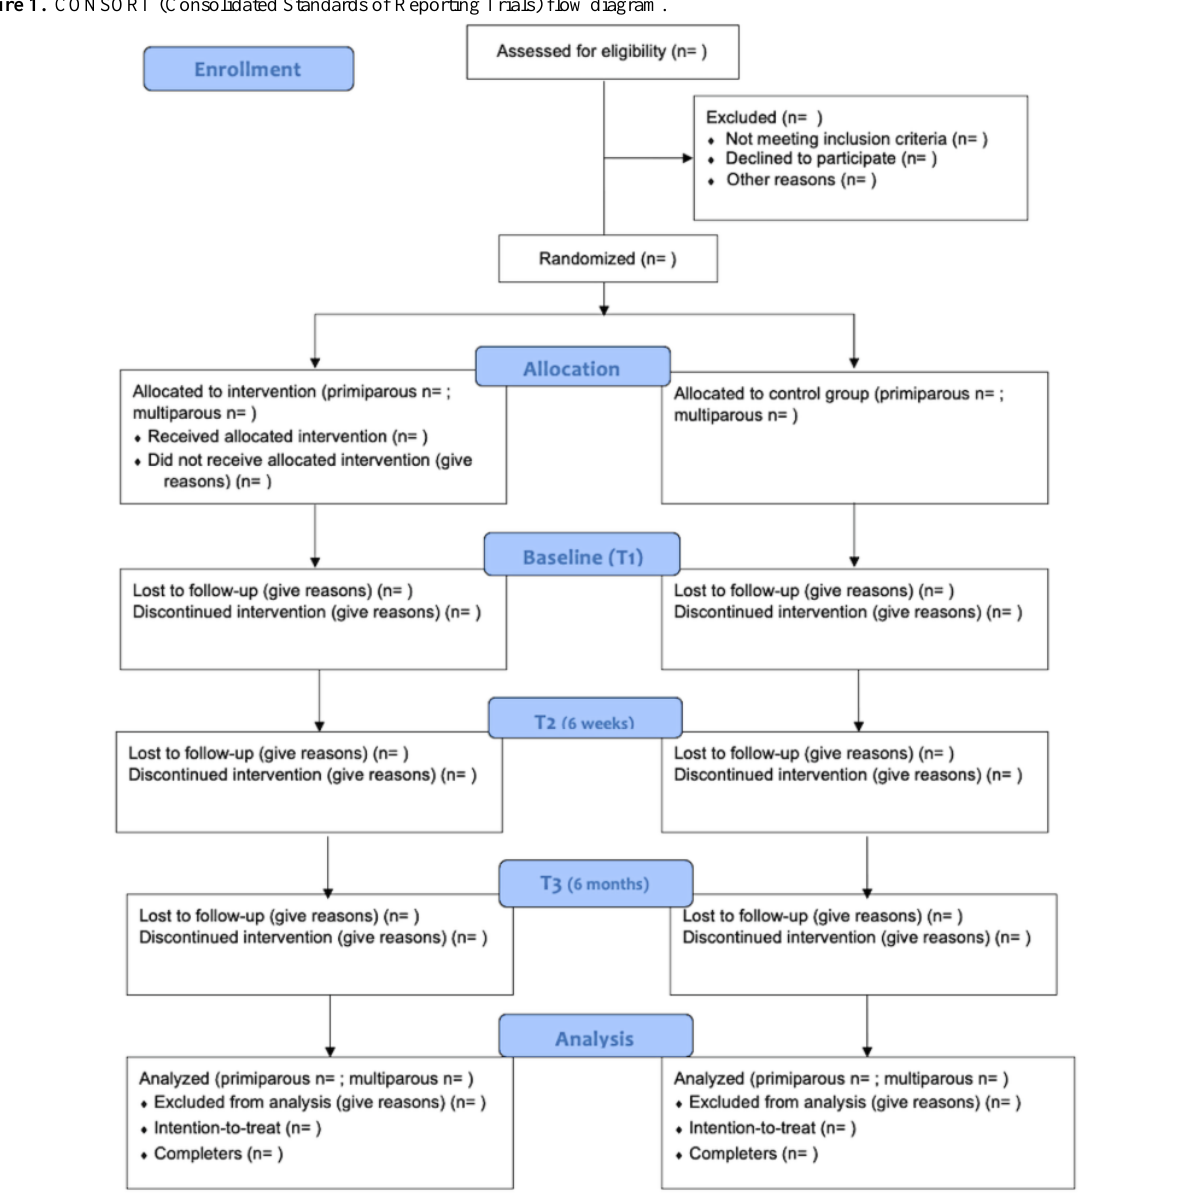
Figure 1. CONSORT (Consolidated Standards of Reporting Trials) flow